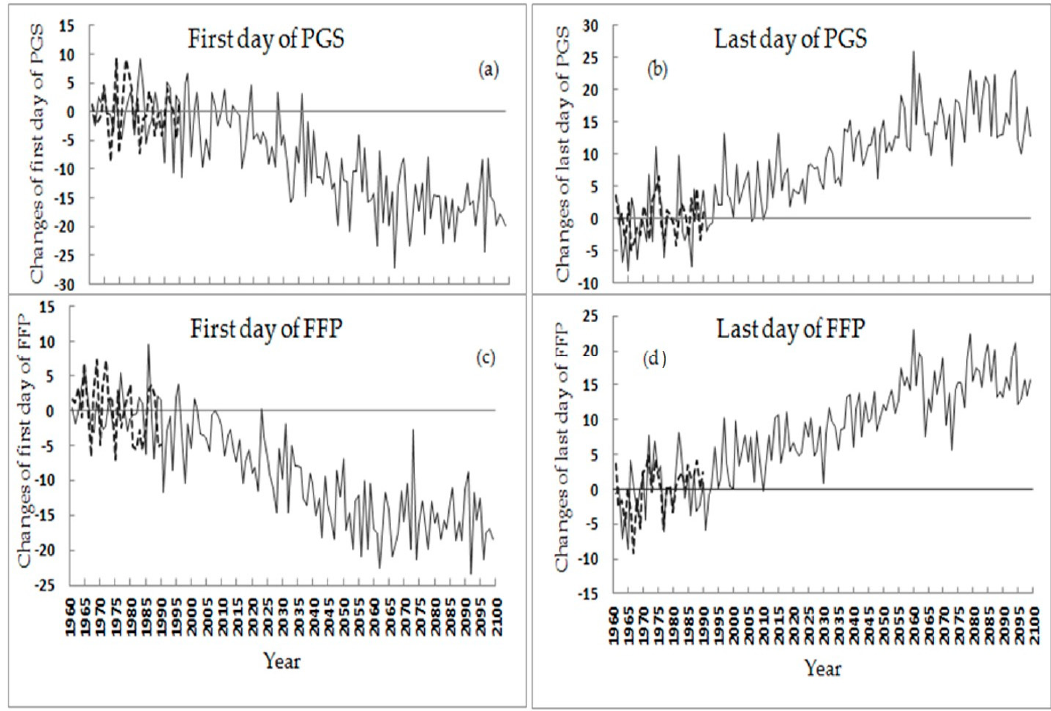
Figure 7. Changes of first and last days of PGS and FFP over the baseline and the 21st century: ( a ) first day of PGS; ( b ) last day of PGS; ( c ) first day of FFP; ( d ) last day of FFP. The solid lines represent the dates under the RCP 4.5; the break lines represent the dates extracted for observation during the baseline.